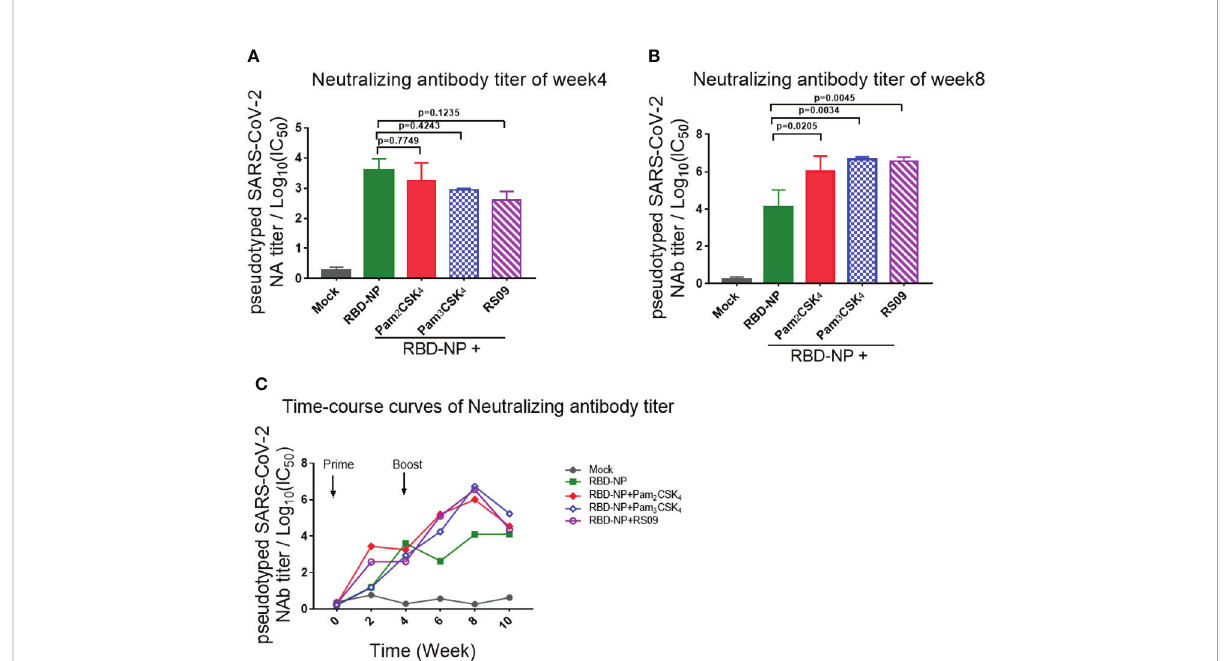
FIGURE 3 Detection and comparison of the neutralizing antibodies titer elicited by TLR agonist-adjuvanted SARS-CoV-2 nanoparticle vaccine. (A – C) Mice were immunized with the Prime/Boost strategy. Neutralizing antibody titers were detected by pseudotyped SARS-CoV-2 virus neutralization assay, which re fl ected the capability of antibodies to block the virus entry (n=5). Log 10 (IC50) indicates neutralizing antibody titers. (A) Time course curve from week 0 to week 10; (B) Neutralizing antibody titer at week 4; (C) Neutralizing antibody titer at week 8. Experiments were performed independently at least 3 times. One-way ANOVA was used in Tukey ’ s multiple comparison test. Experimental data are expressed as Mean ±